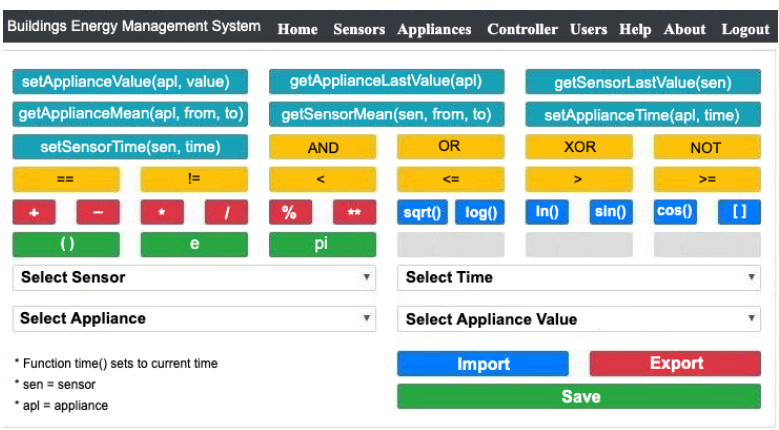
Figure 3. The homepage of GUI.